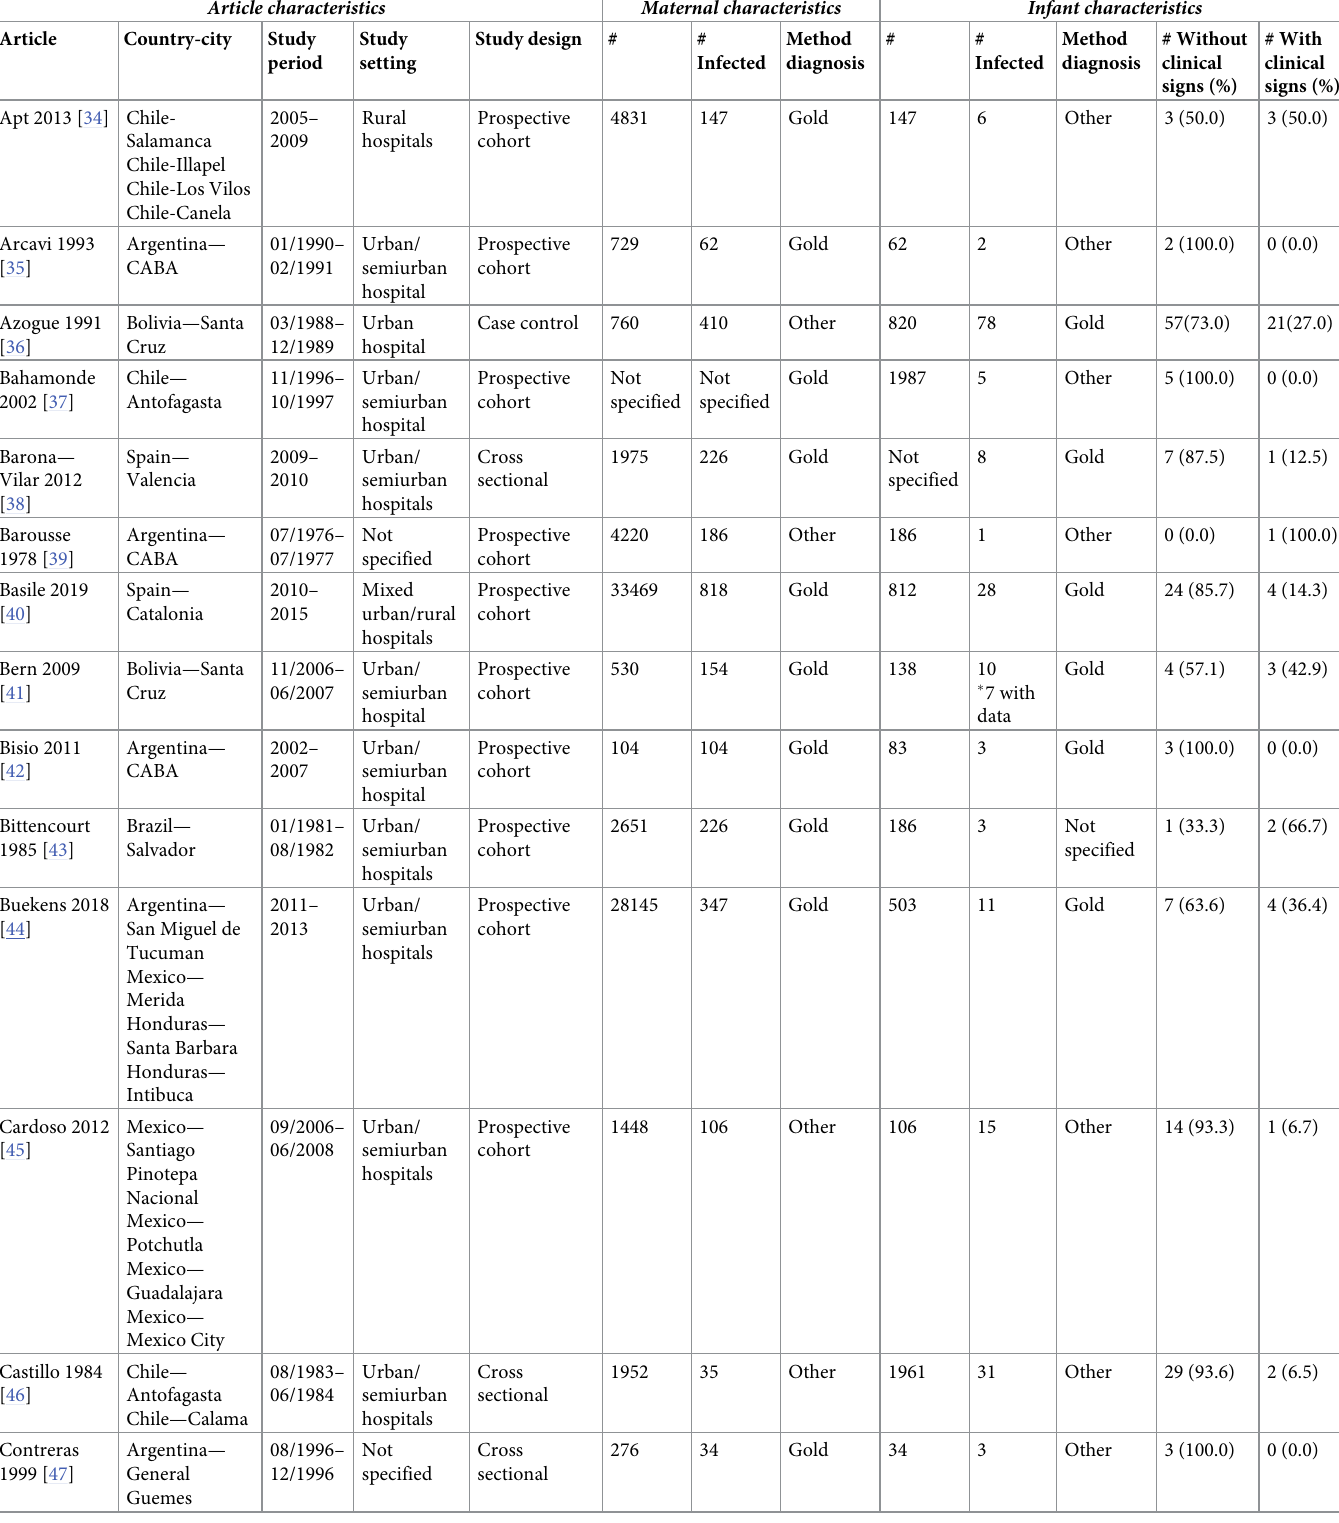
Table 1. Characteristics of included articles and their study